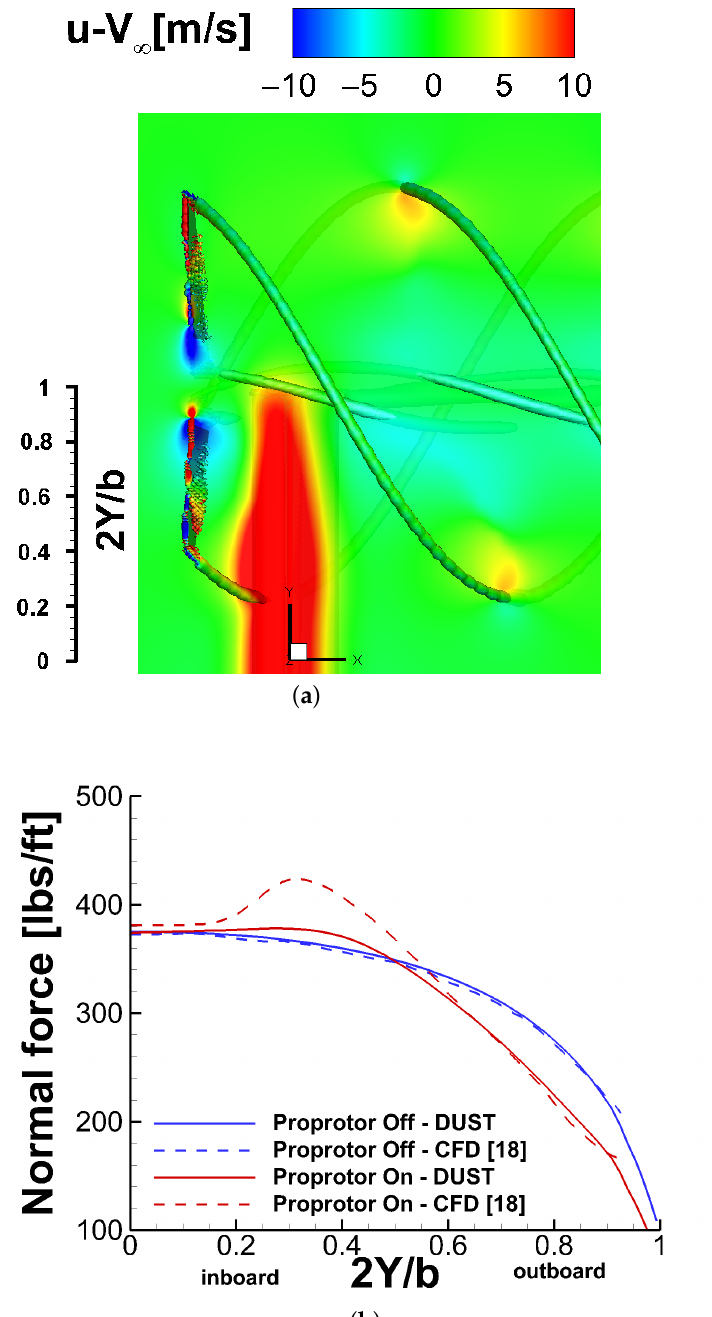
Figure 11. Numerical results for blade azimuth ψ = 310 ◦ , α = 5 ◦ , V ∞ = 220 kts, Ω = 517 RPM: ( a ) iso-surface of Q-criterion with contours of the slipstream perturbation velocity over an X − Y plane at 0.6 m from the proprotor center computed by DUST; ( b ) comparison of the spanwise normal force distribution on the